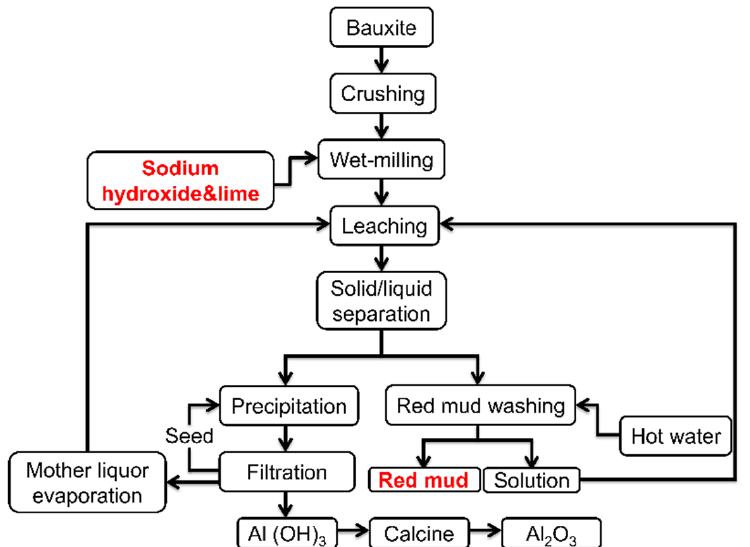
Figure 1. The flow chart of the Bayer process [20].